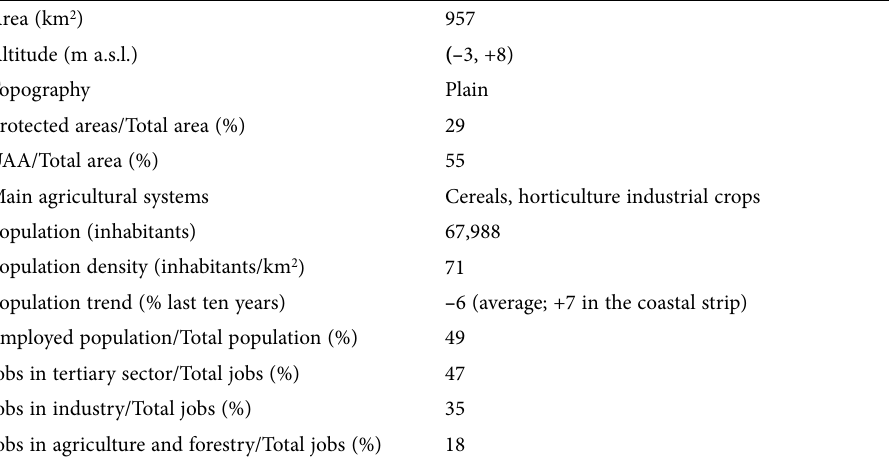
Table 1. General features of the case study area (data: National Institute of Statistics). Area (km 2 ) 957 Altitude (m